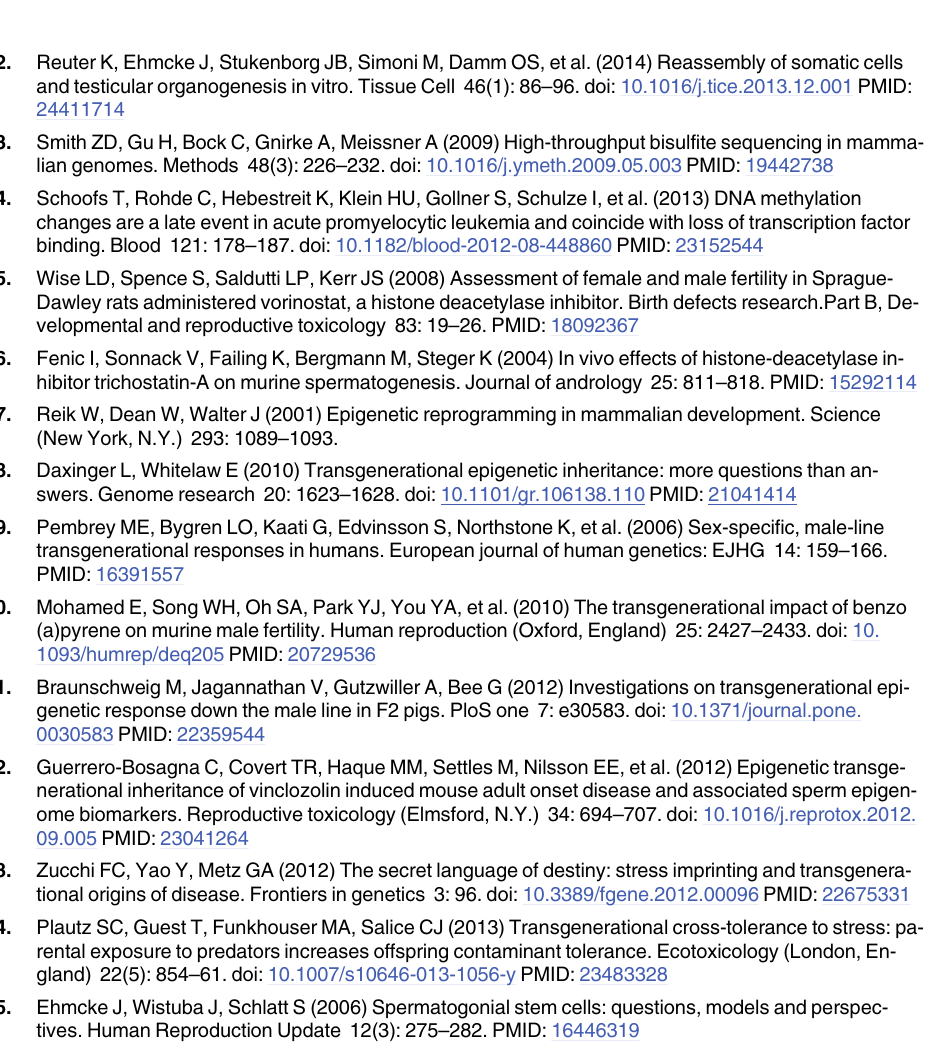
PLOS ONE | DOI:10.1371/journal.pone.0117839 February 18,